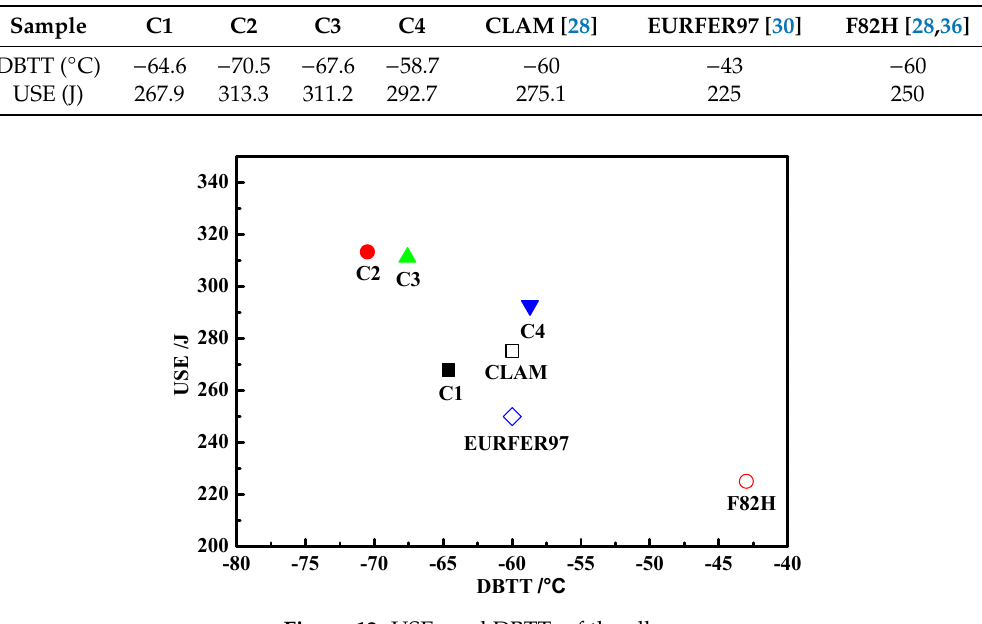
Figure 12. USEs and DBTTs of the alloys.